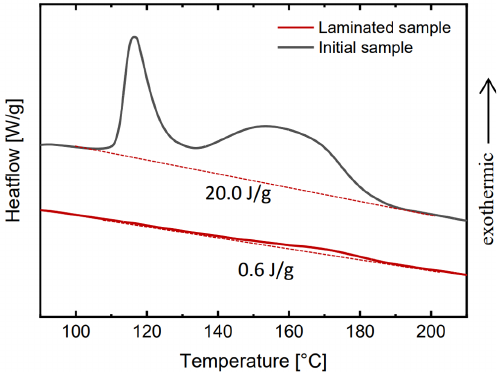
Figure 8. Typical DSC thermograms of uncured and laminated